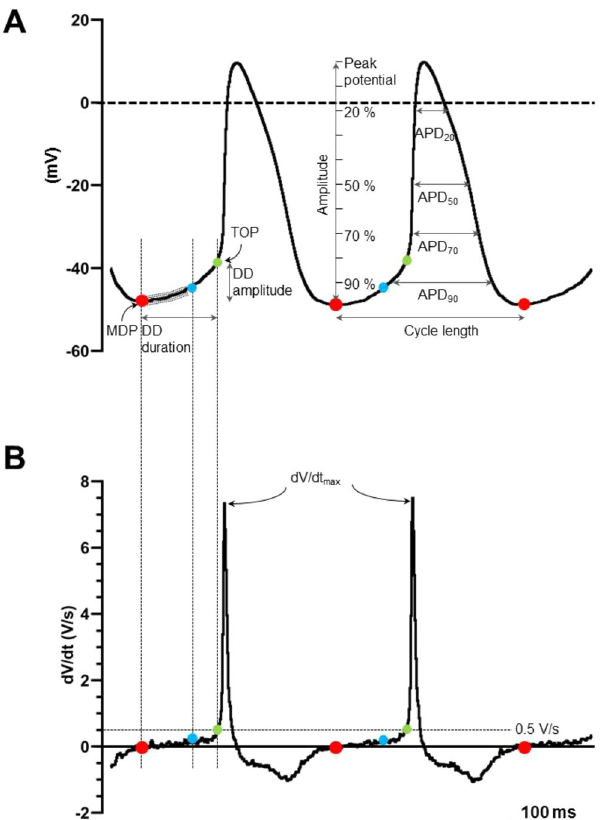
Figure 8. Action potential parameters and measurements. Representative action potential record from the leading pacemaker site in a rat sinus node preparation (mV scale in A ) and corresponding first time derivative dV/dt (mV/s scale in B) are shown. The maximum diastolic potential (MDP, filled red circle), take-off potential (TOP, filled green circle), diastolic depolarization (DD) duration (time interval between MDP and TOP) and DD amplitude (difference between TOP and MDP) are indicated ( A ). The DD slope for each action potential record was calculated as the mean of dV/dt values ( B , mV/s) in the early two-thirds fraction (shaded interval between red and blue circles in panel A) of the DD duration. Peak potential was noted as the maximum potential reached ( A , mV), amplitude calculated as difference between MDP and peak potential and maximum upstroke velocity was the maximum dV/dt value reached ( B , mV/s). The time dependent variables of the action potential viz . cycle length and APD at 20%, 50%, 70% and 90% repolarization was measured as